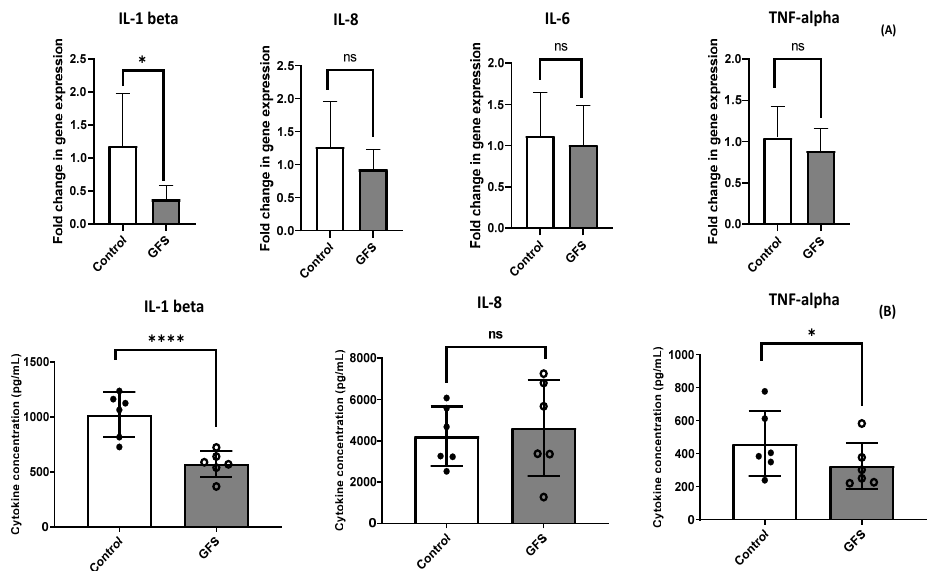
Figure 2. Effect of GFS diet on proinflammatory cytokines in the colon of weaned piglets. ( A ) Fold change in gene expression of proinflammatory cytokines IL-1 beta, IL-8, IL-6 and TNF-alpha in the colon of control (white columns) and GFS-treated (grey columns) piglets. ( B ) Concentration of proinflammatory cytokines IL-1 beta, IL-8 and TNF-alpha in the colon of control (white columns) and GFS-treated (grey columns) piglets. The results are displayed as mean ± standard error (SE). * indicates a significant difference between control and GFS-treated piglets ( p < 0.05). **** indicates a highly significant difference between control and GFS-treated piglets ( p < 0.0001). ns indicates nonsignificant difference.